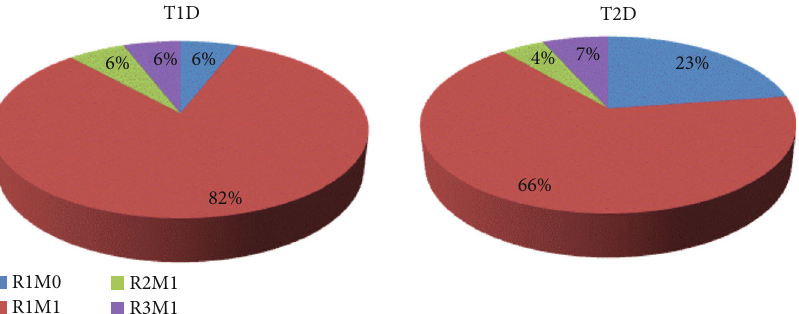
Figure 2: Distribution of the diabetic retinopathy according to the type of diabetes mellitus. DM: diabetes mellitus; T1D and T2D: type 1 and 2